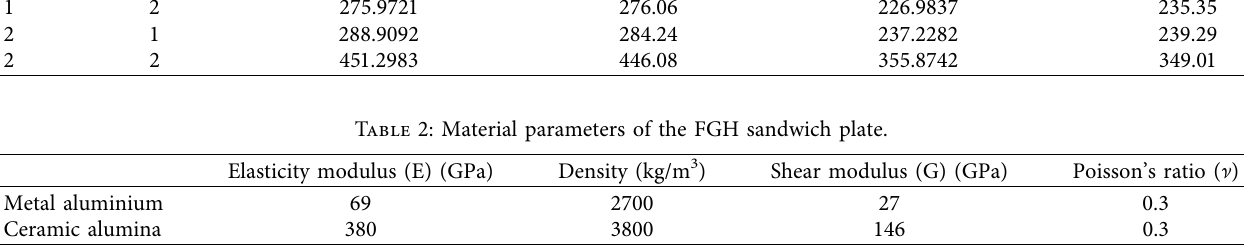
Table 3: Type A: the first five natural frequencies ω of the simply supported FGH sandwich plate. Volume fraction index (N)